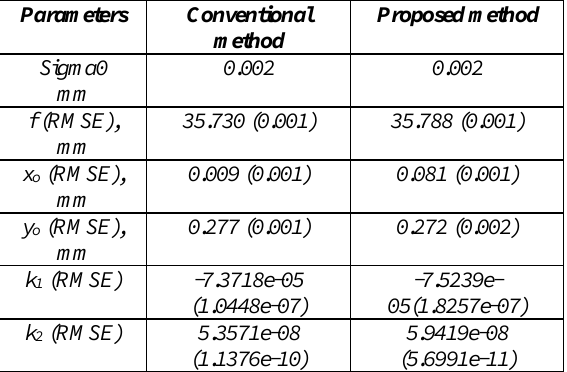
Table 2. The calibration results for real